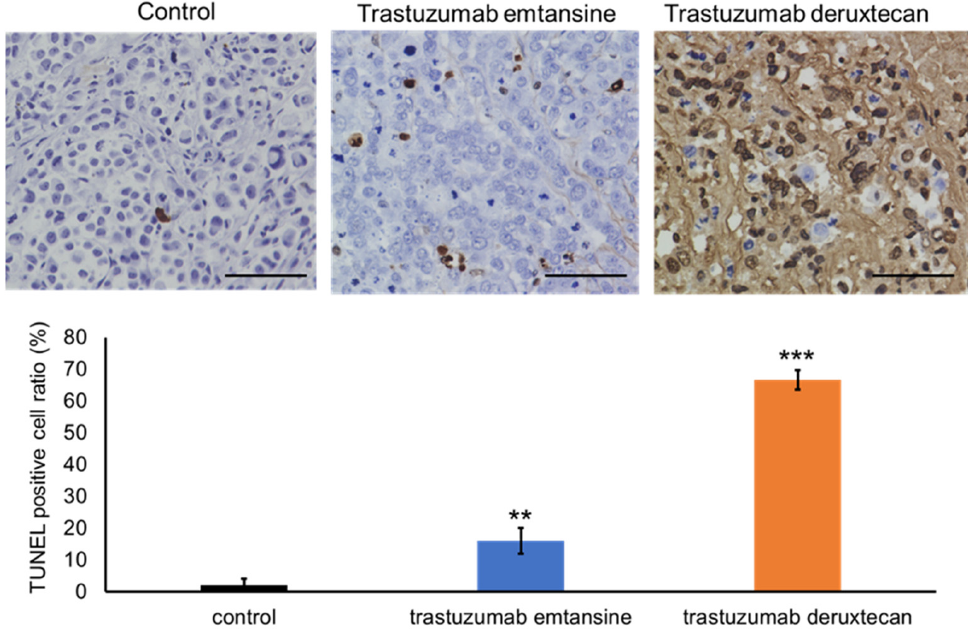
Figure 3. The positive ratio of TUNEL staining is markedly higher in the EMPD-PDX-H1 tumors treated with HER2-targeted ADC than in the untreated control tumors. EMPD tumors were treated with HER2-targeted ADCs (trastuzumab emtansine or trastuzumab deruxtecan). After 48 h, the tumors were extracted and were assessed by TUNEL staining. Upper: Representative images of TUNEL staining (scale bar = 100 µ m). Lower: The ratio of TUNEL-positive cells was examined (columns, mean percentage of TUNEL-positive cells, n = 3, determinations based on examination of 100 tumor cells; bars, SD). ** p < 0.01, *** p < 0.001; compared to control tumors, by t